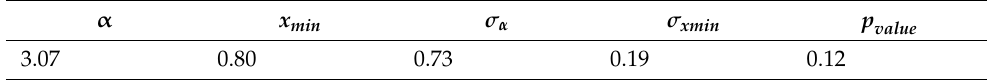
Table 4. Parameters of the power-law model for the pyroclastic volume dataset.